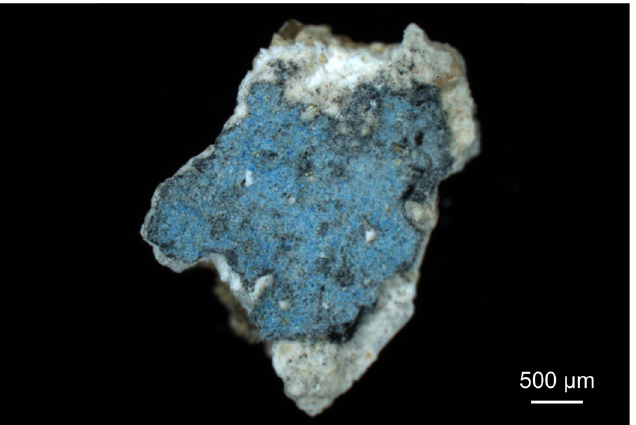
Figure 2. Darkfield light microscopy image of a patch of the pictorial layer of the mural fragment, consisting of Egyptian blue (on the top), grey underpainting, white lime wash and beige